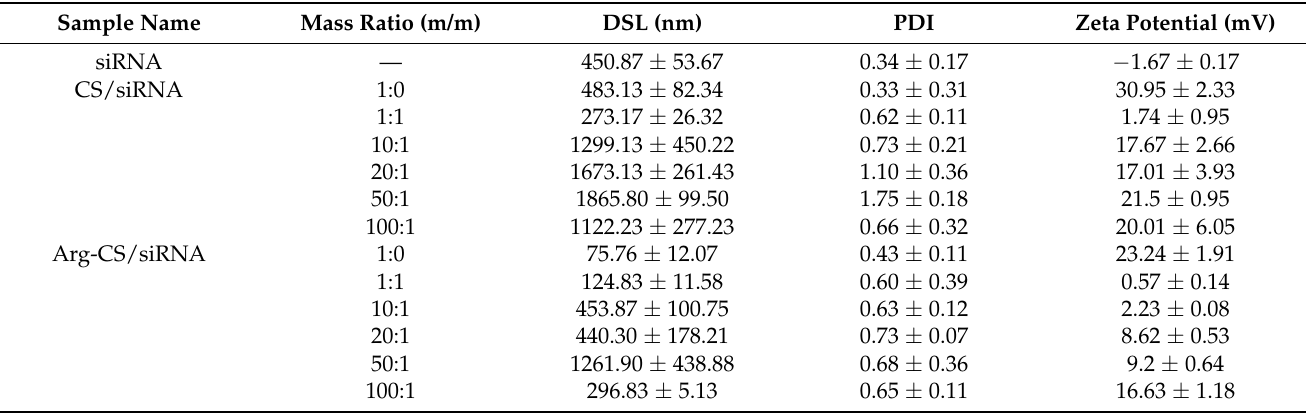
Table 1. The summary of physiochemical properties of the Arg-CS/siRNA complex.